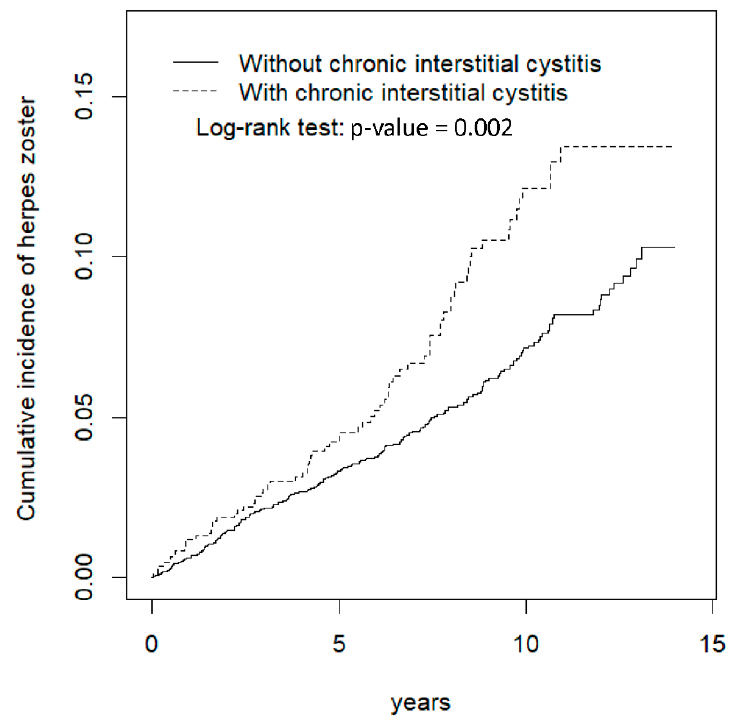
Figure 1. Cummulative incidence comparison of herpes zoster for patients with (dashed line) or without (solid line) chronic interstitial cystitis.